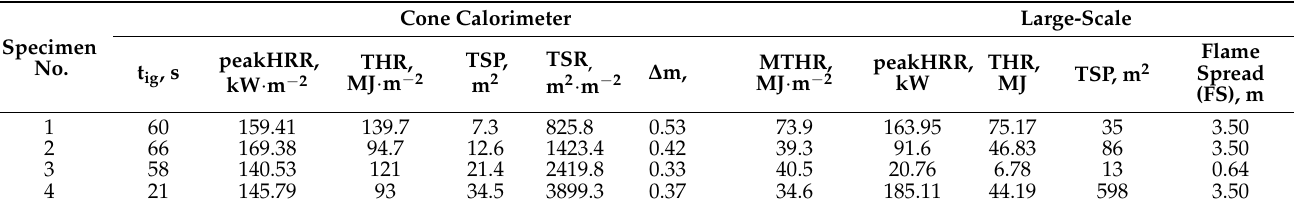
Table 5. Cone calorimeter and large-scale experiment results for four cable